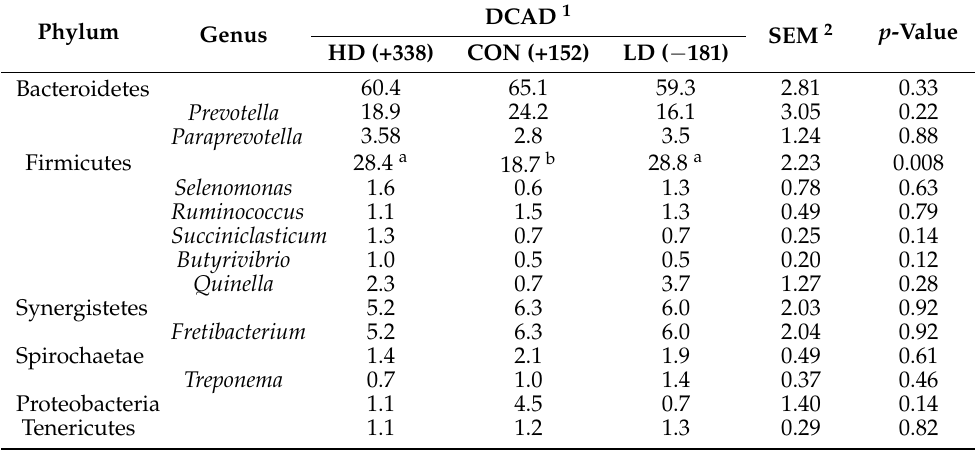
Table 5. Effect of varying dietary cation-anion difference on relative abundance (%) of bacteria taxa > 0.1% of average abundance in the rumen fluid of female